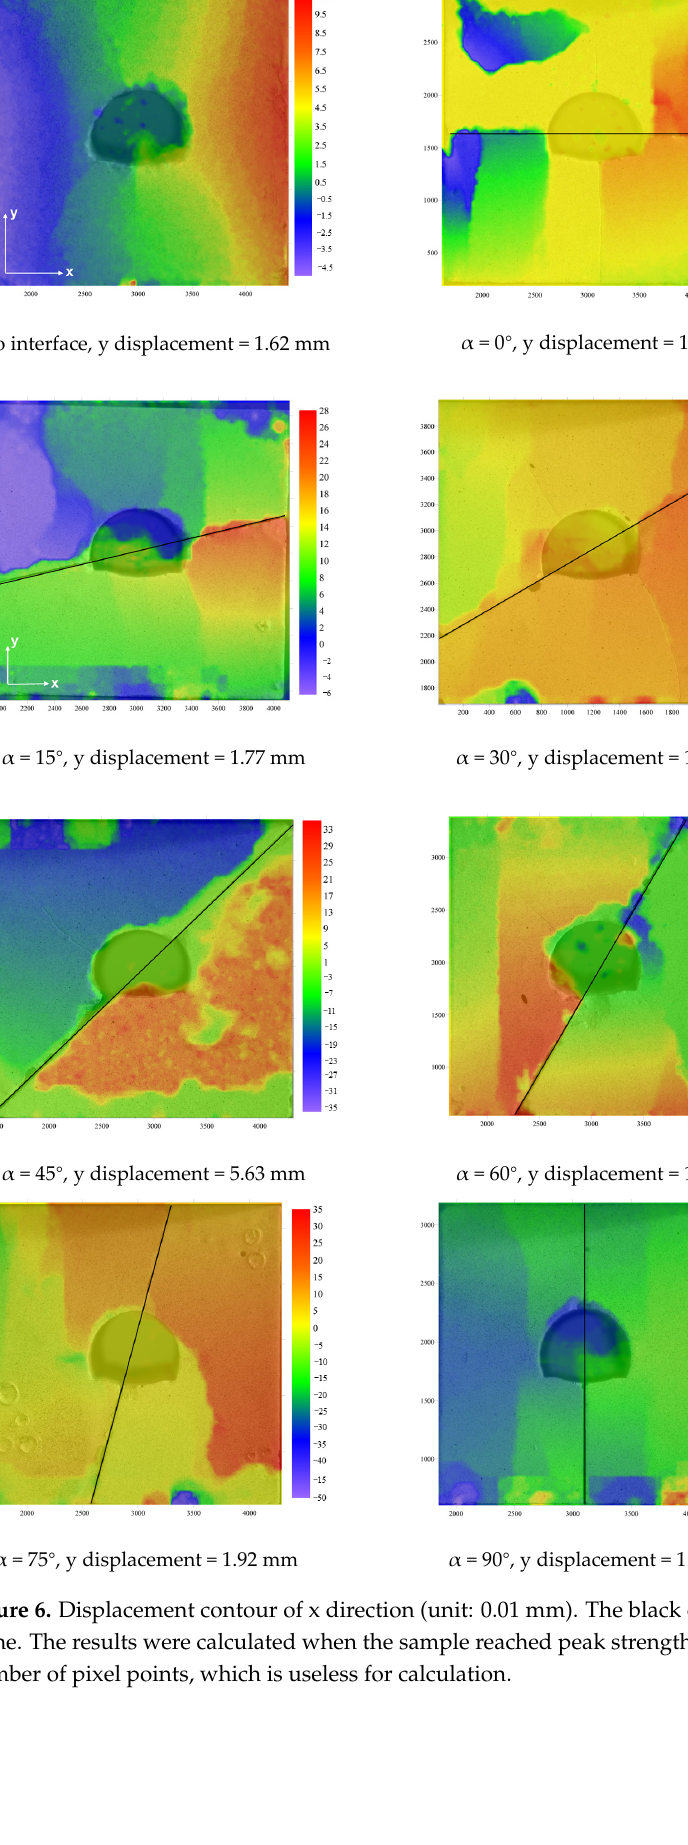
Figure 7. Crack development. Under the action of pressure, the paint on the surface is detached from the sample, resulting in uneven surface.